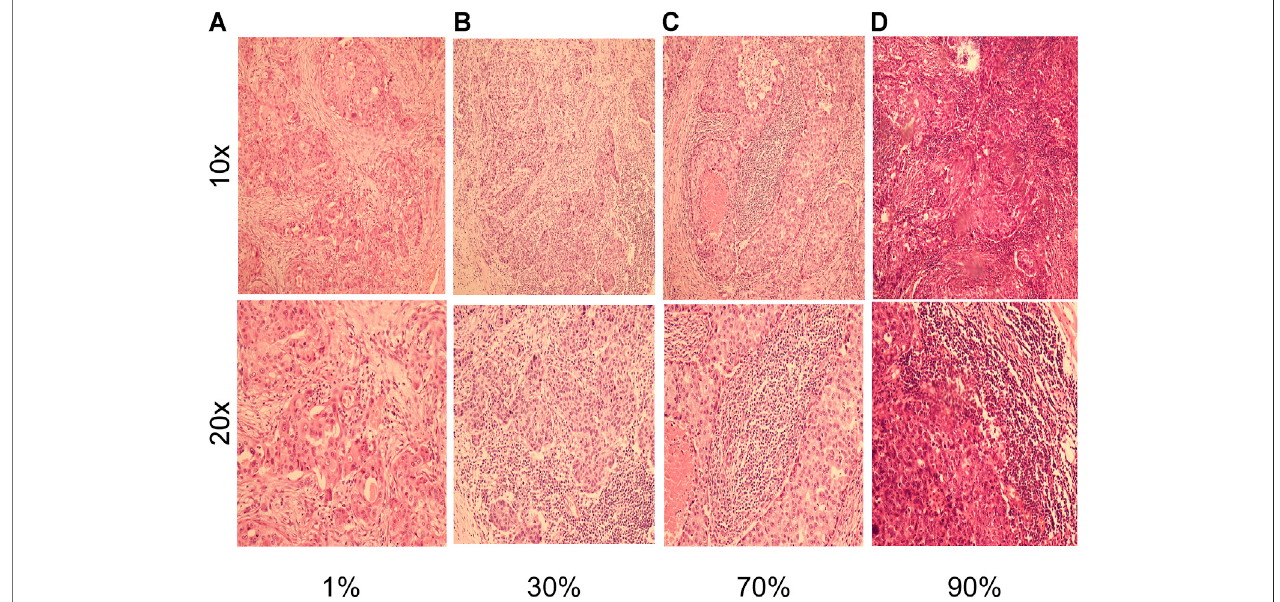
FIGURE 1 | H and E staining with of breast cancer tissues, shown at 10 × magni fi cation (inset at 100 × ) and 20 × magni fi cation (inset at × 200). (A) Representative images of H and E in a breast cancer patient with 1% TILs density at 10x and 20x magni fi cations. (B) Representative images of H and E in a breast cancer patient with 30% TILs density at 10x and 20x magni fi cations. (C) Representative images of H and E in a breast cancer patient with 70% TILs density at 10x and 20x magni fi cations. (D) Representative images of H and E in a breast cancer patient with 90% TILs density at 10x and 20x magni fi